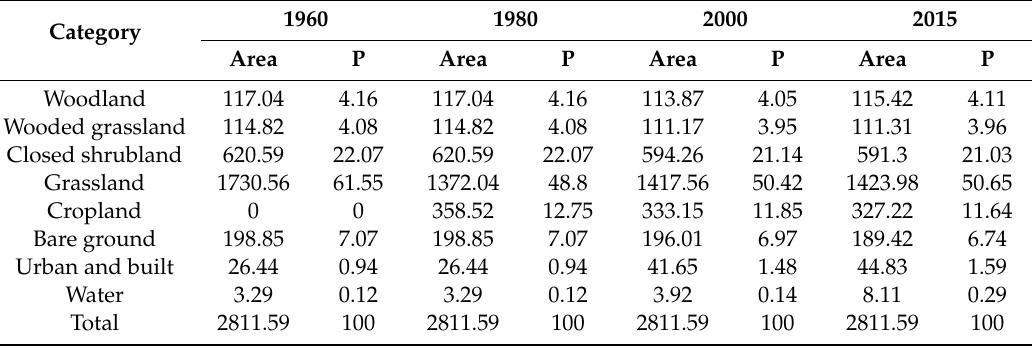
Table 2. Land use / cover type area (units: km 2 ) and proportion (P; units: %) in the Beichuan River Basin in 1960, 1980, 2000, and 2015.